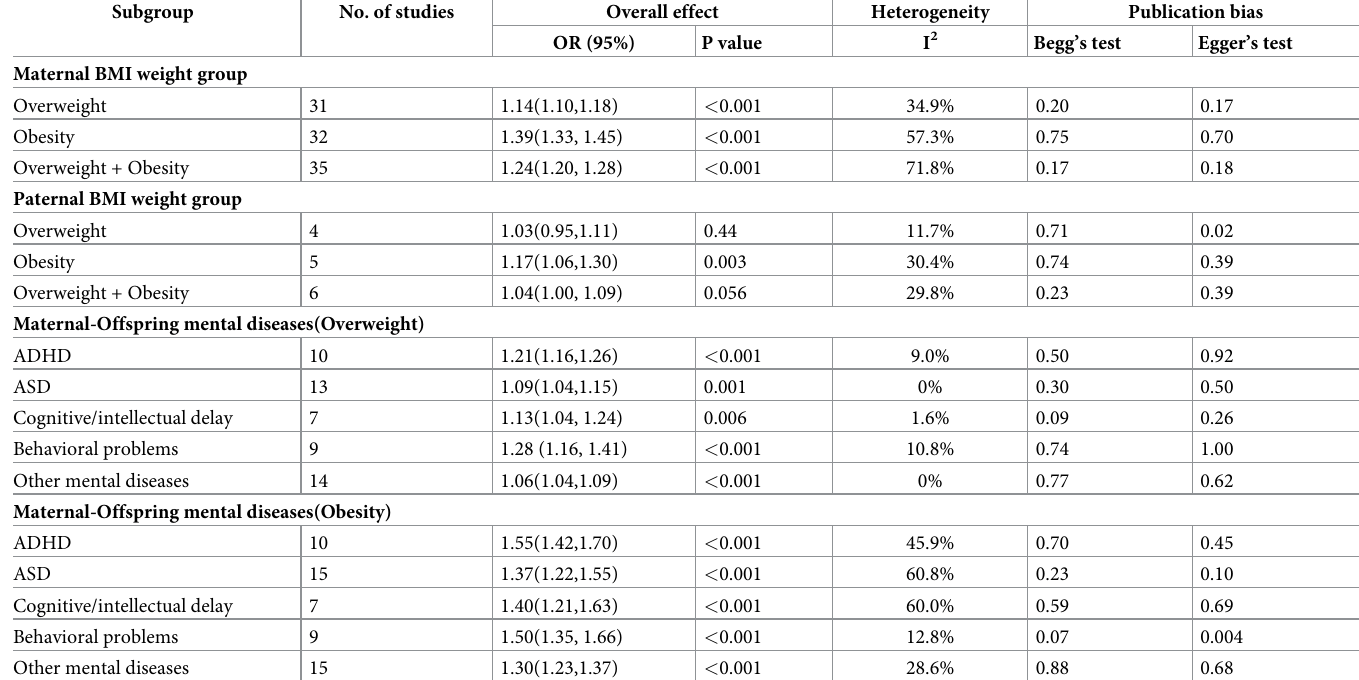
Table 3. Summary of